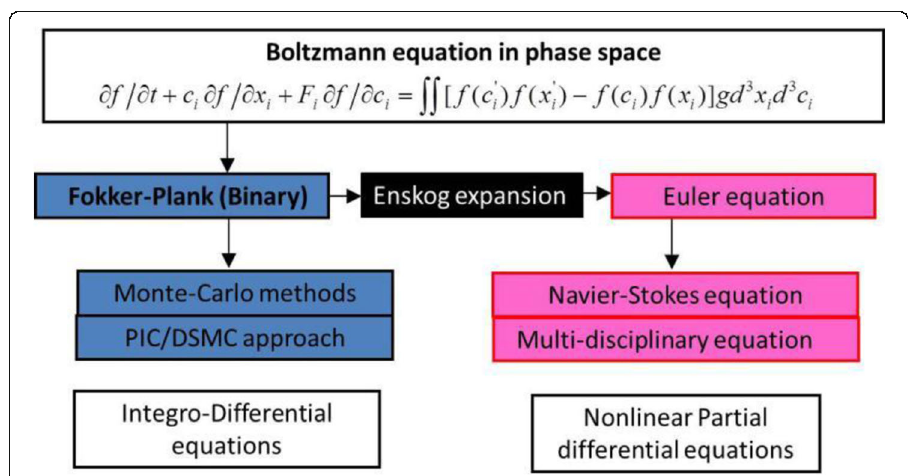
Fig. 1 The hierarchy of conservation